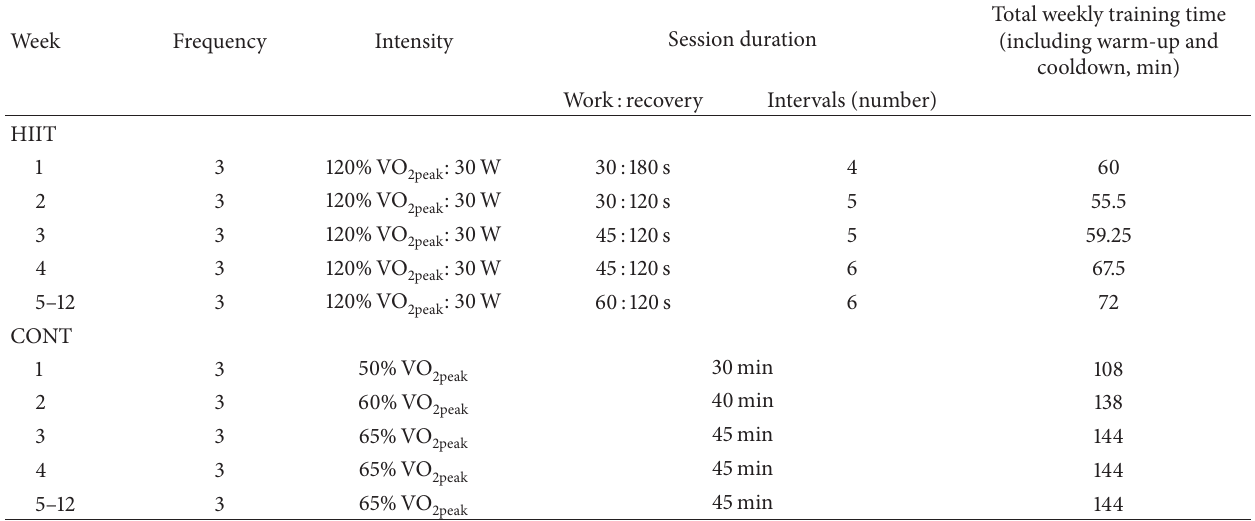
Table 1: Description of exercise interventions.